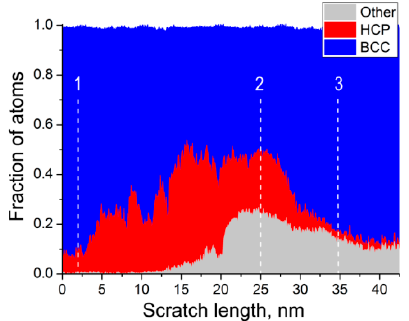
Figure 9. Fractions of atoms with different configurations of crystal lattice in fragment “A” of the β -Ti inclusion as a function of the scratch length. Vertical dashed lines 1, 2 and 3 mark positions of the indenter corresponding to the atomic structures shown in Figure 8b–d, respectively.